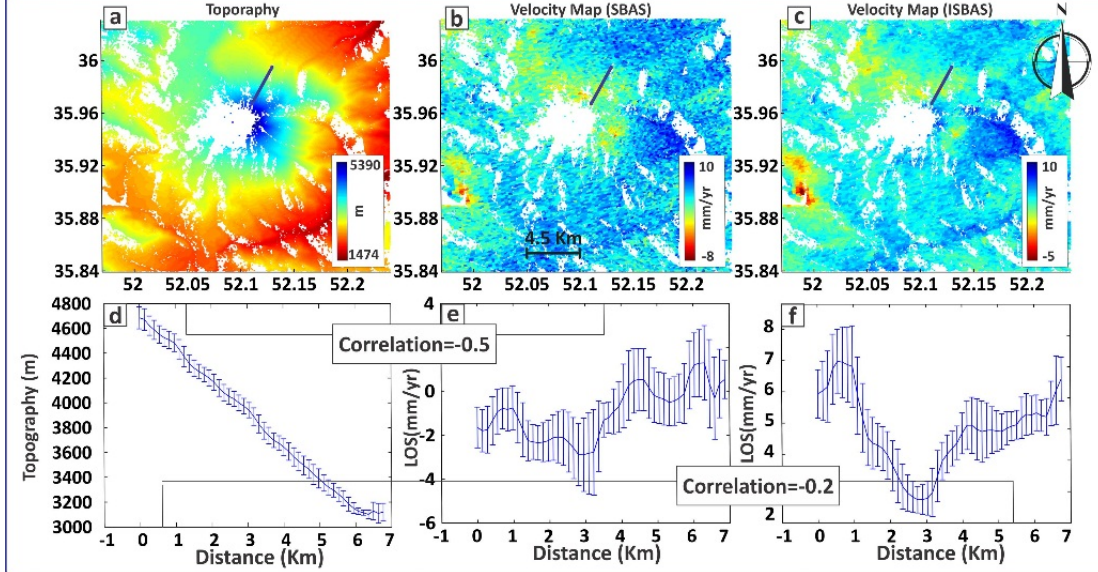
Figure 8. ( a ) Topographic map. ( b ), ( c ) are ground deformation velocity maps from Envisat ascending dataset calculated by standard SBAS and ISBAS methods, respectively. ( d ) Topographic profile extracted from (a). ( e ) and ( f ) are displacement profile extracted from (b) and (c), respectively. Correlation coefficients were determined at the 95% significance